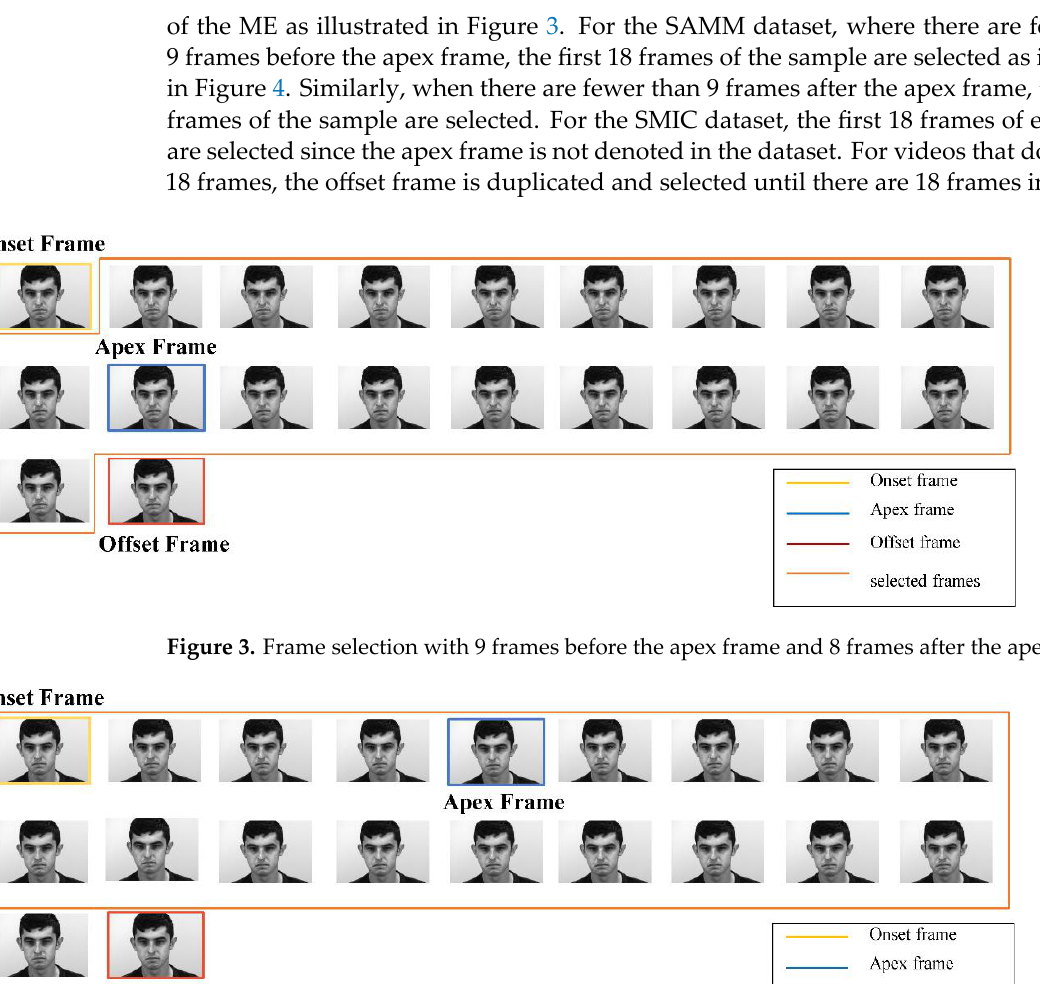
Figure 4. Frame selection with less than 9 frames before the apex frame.